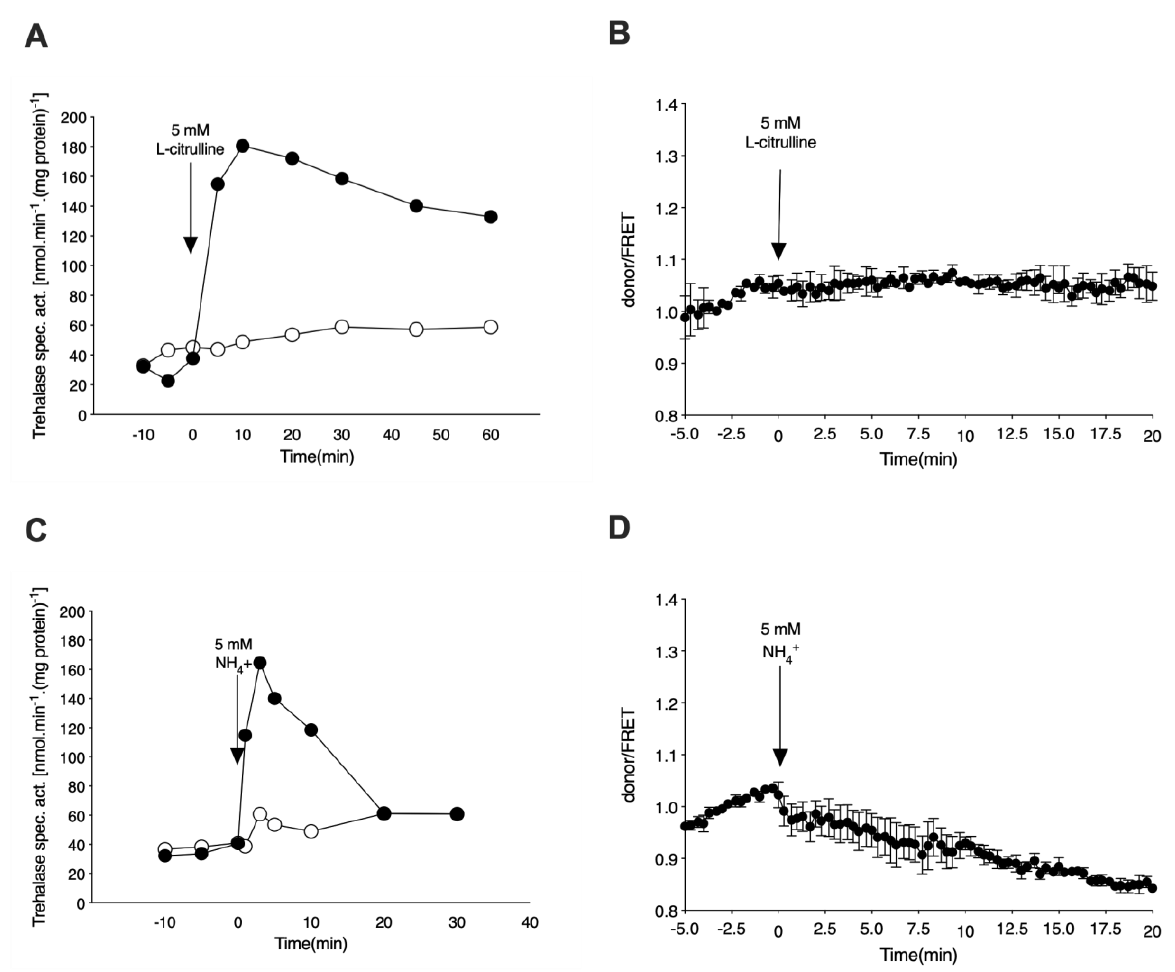
FIGURE 2: Nitrogen activates PKA in a transceptor-dependent, cAMP-independent manner. (A) Activation of the PKA target trehalase in nitrogen-starved cells after addition of 5 mM L-citrulline. Strains: wild type (closed circles) and gap1 ∆ (open circles). (B) Donor/FRET levels for cAMP determination in vivo after addition of 5 mM L-citrulline to nitrogen-starved cells of the wild type strain. (C) Activation of the PKA target trehalase in nitrogen-starved cells of the wild type strain after addition of 5 mM (NH 4 ) 2 SO 4 . Strains: wild type (closed circles) and mep2 ∆ (open circles). (D) Donor/FRET levels for cAMP determination in vivo after addition of 5 mM ammonium sulfate to nitrogen-starved cells of the wild type